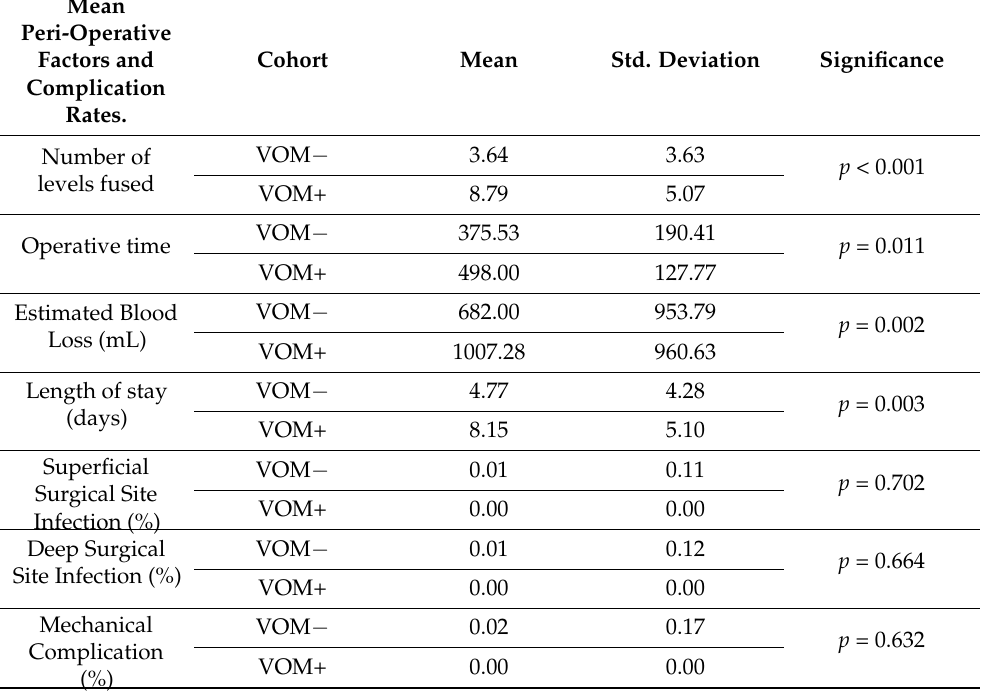
Table 3. Surgical and peri-operative comparisons of VOM+ and VOM −